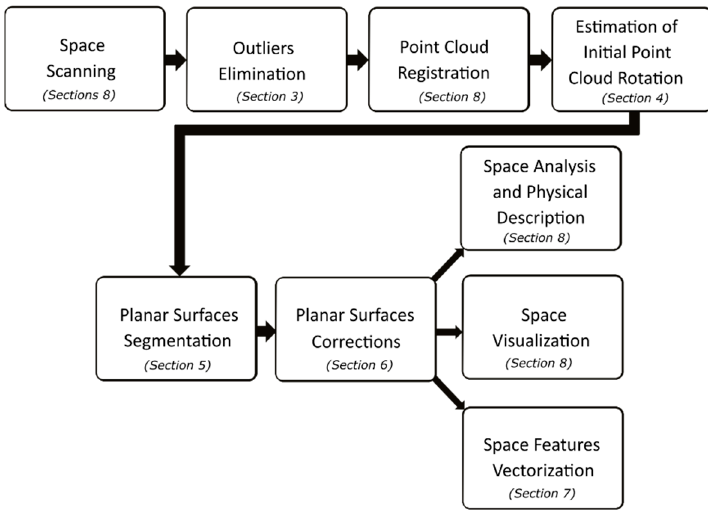
Figure 1. Proposed point cloud processing block diagram.